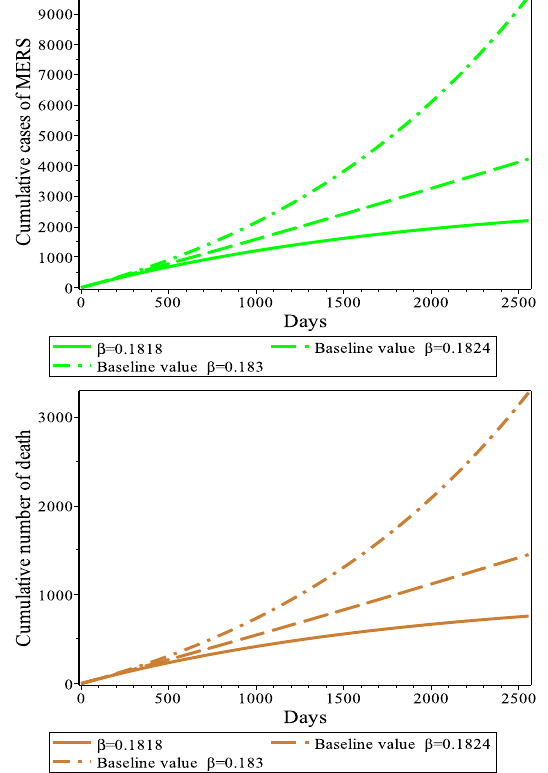
Fig. 7: Saudi Arabia. Simulation results of the first case, for the cumulative reported cases of MERS (T) and the cumulative number of deaths (B). Parameter values used are β = 0 . 1818 – solid curves; β = 0 . 1824 –dashed; and β = 0 . 1830 – dash-dot